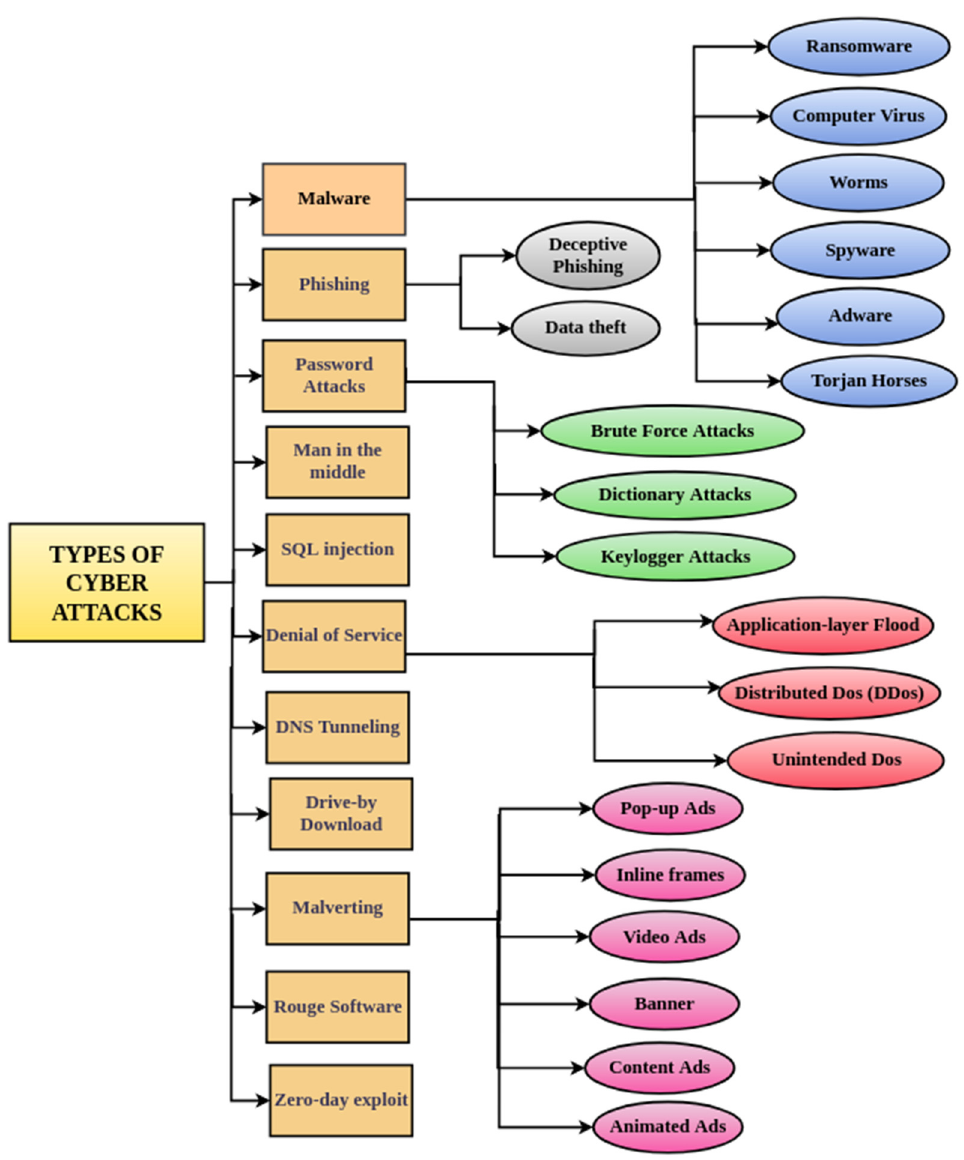
Figure 8. Nomenclature of cyber-attacks used in this review.